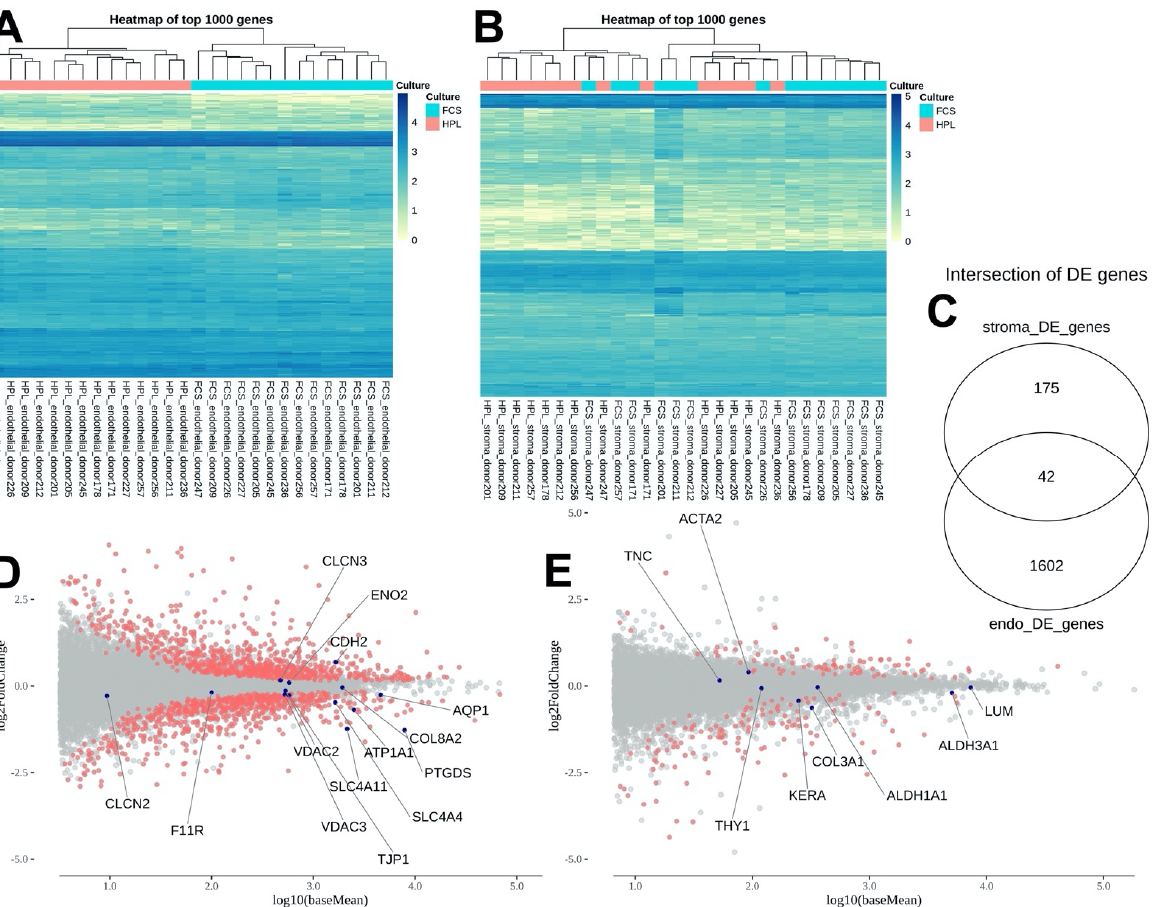
Figure 2. Next generation sequencing data of the stroma and Descemet membrane/endothelium (DmE) complex of the donor corneas after 25 days of differential culture conditions in either 2% HPL or 2% FBS-containing medium. Heat-maps of the top 1000 genes ranked by adjusted p -value comparing the differential gene expression patterns of the DmE ( A ) and stroma ( B ). In total, 1602 genes were differentially regulated in the DmE and 175 in the stroma, while 42 were differentially regulated in the stroma as well as the DmE ( C ). MAplot of the differences in the expression of known marker genes for corneal endothelial ( D ) and stromal cells ( E ). Table 4. Top 10 differentially up- and downregulated genes of the corneal endothelium and stroma following 25 days of paired culture in either 2%FBS or 2%HPL.